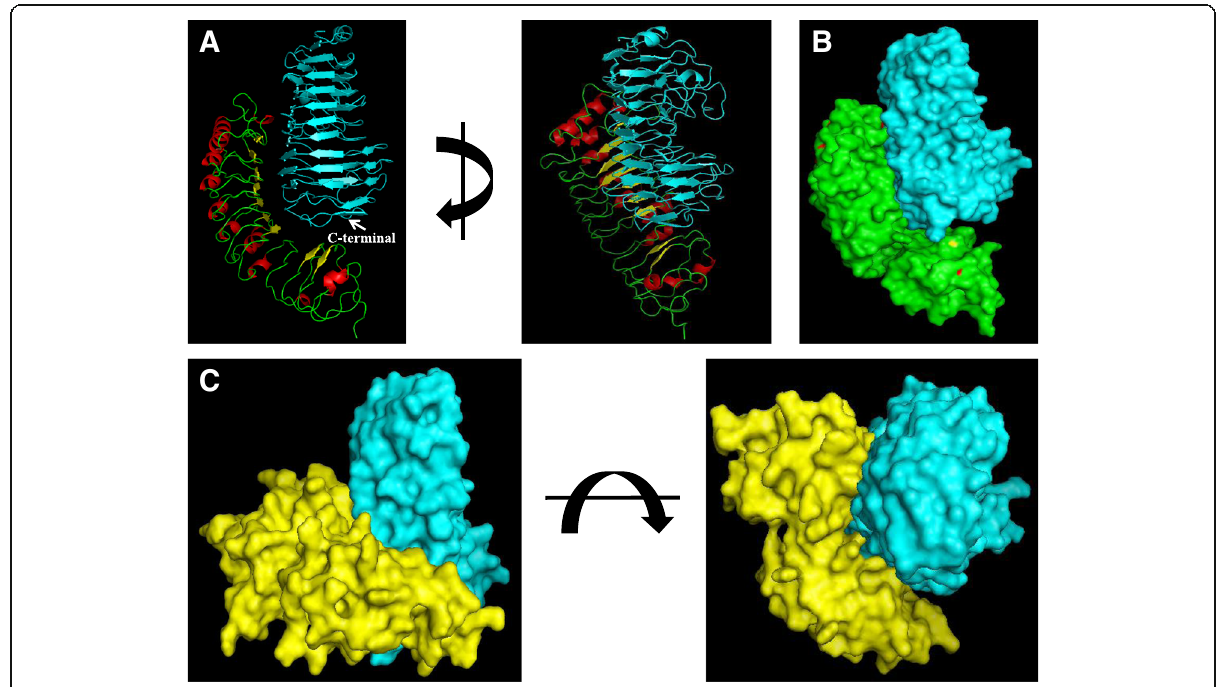
Fig. 2 Comparative analysis of OsPGIP1-RsPG1 and OsPGIP2-RsPG1. a , Cartoon representation of the complex formed by OsPGIP1 (red and yellow) and RsPG1 (cyan blue). Two orthogonal perspectives are shown. b , Surface representation of the complex formed by OsPGIP1 (green) and RsPG1 (cyan). c , Surface representation of the complex formed by OsPGIP2 (yellow) and RsPG1 (cyan). Two orthogonal views are shown.